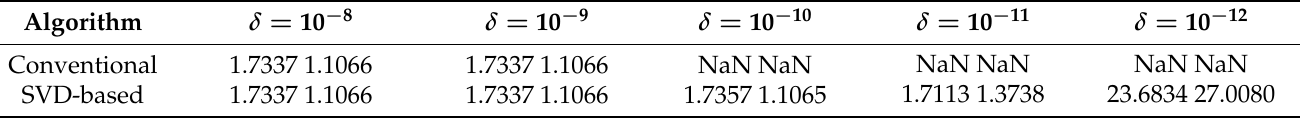
Table 8. Matlab: mean absolute errors ( φ , θ ) of estimated angles (degrees).